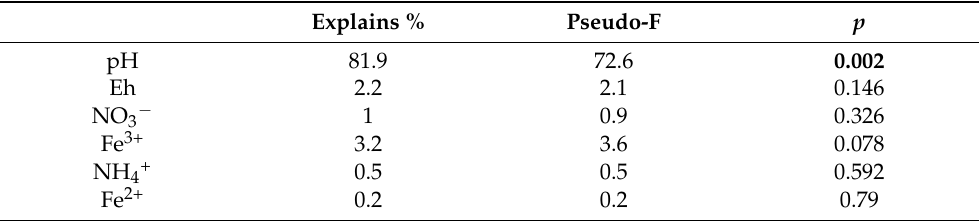
Table 4. Redundancy analysis (RDA) through Monte Carlo permutation test for the effects of soil properties on AOA, AOB, and nirK and nosZ gene abundance.